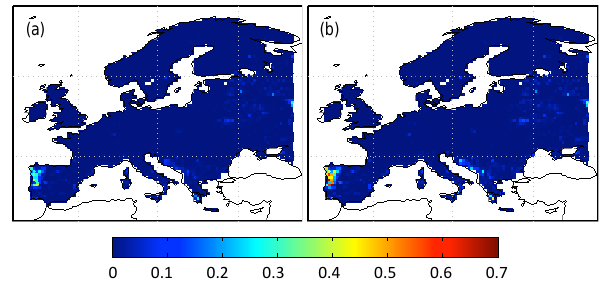
Figure 6. Wildfire PM 2 . 5 emissions during peak fire season dis- played on linear scale, in g(m 2 month) − 1 : (a) current and (b)